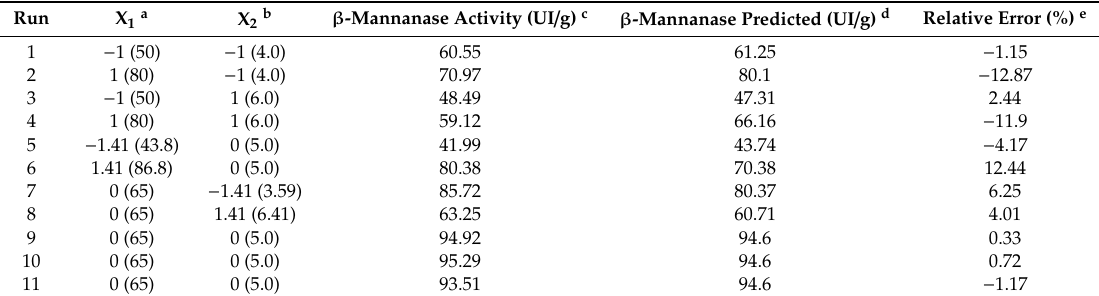
Table 5. Experimental conditions and results of the central composite rotatable design for the activity of β -mannanase produced by A. niger F12 in a column-type bioreactor at 32 ◦ C and pH 6.0, with addition of 8 mL of Mandels